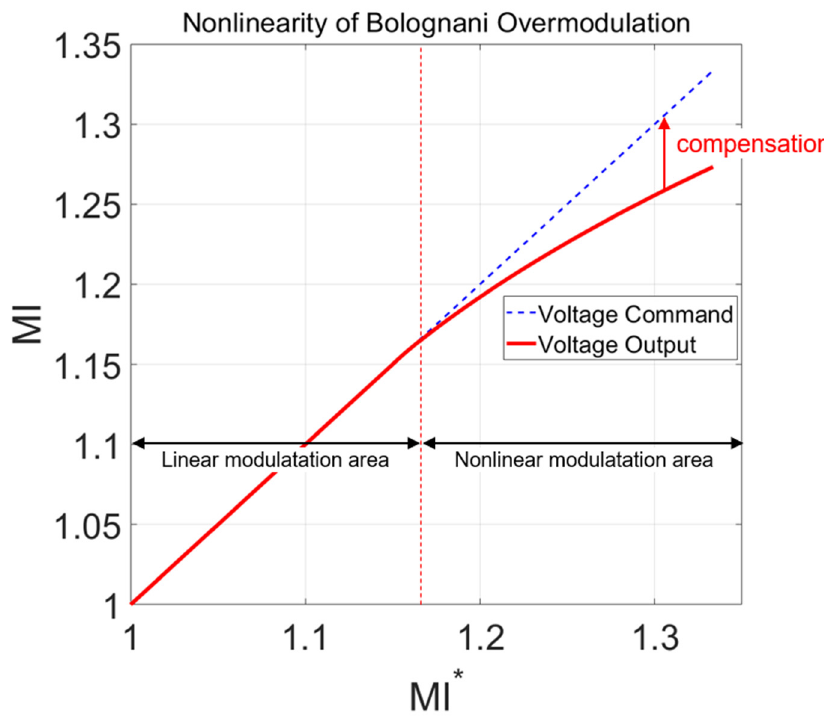
Figure 5. Compensation of the command voltage in the nonlinear overmodulation region.